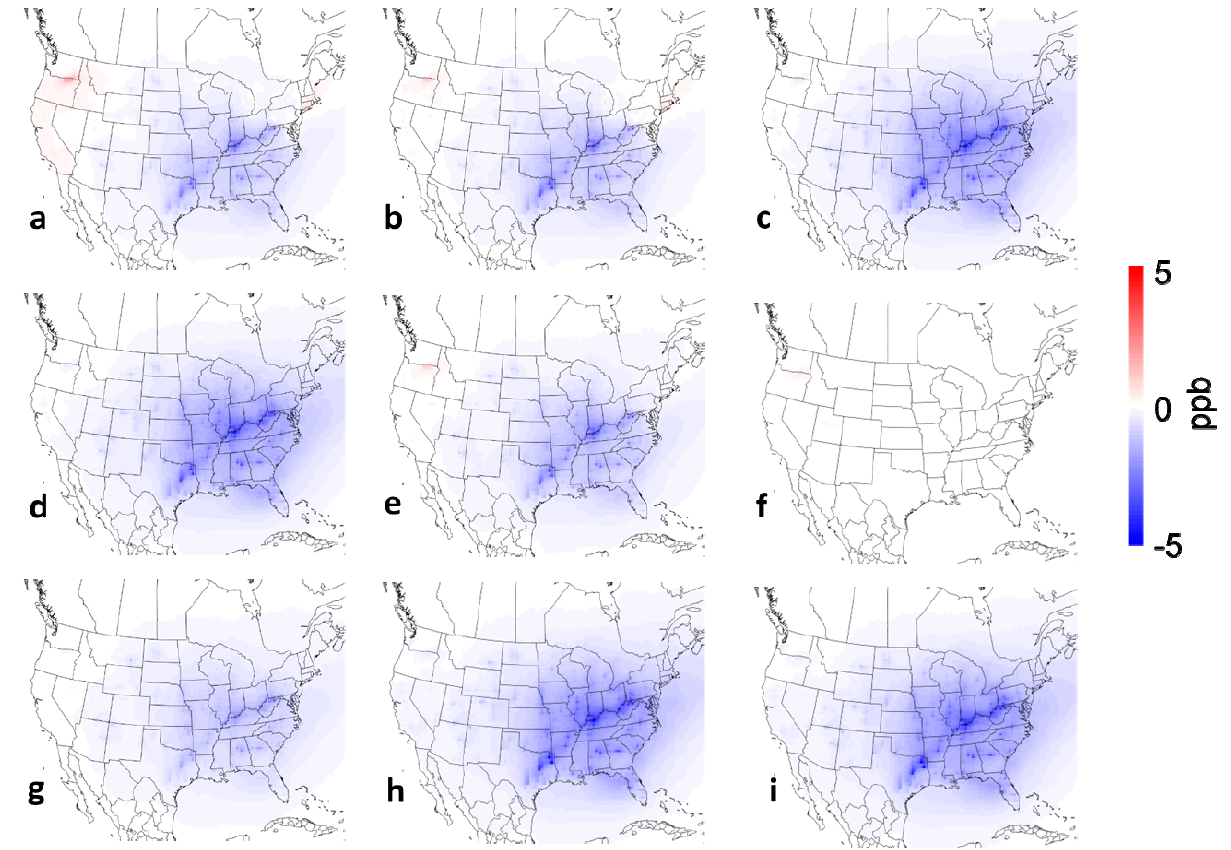
Figure 2. Differences in the seasonal average of the maximum 8 h ozone average concentrations in ppb, across the domain for the year 2050 between BAU and: ( a ) CP-25u, ( b ) CP-50u, ( c ) CAP, ( d ) CAP-B, ( e ) CES40, ( f ) ACE, ( g ) CPP20, ( h ) CES50-H and ( i ) CES50-L.